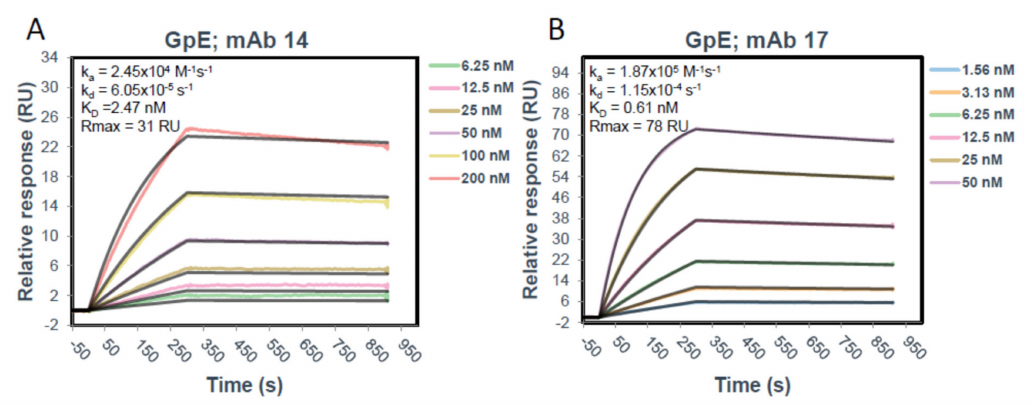
Figure 5. SPR sensograms showing the kinetics of gpE binding to mAb14 ( A ) and mAb17 ( B ) captured with anti-Fc antibody and the calculated kinetic constants. Under the conditions of this experiment, the antibodies bind gpE with high affinity, with mAb17 binding approximately 4 times stronger than mAb14. Additionally, the Rmax of mAb 17 is approximately twice that of mAb and theoretical Rmax possibly indicating that mAb 17 binds a gpE